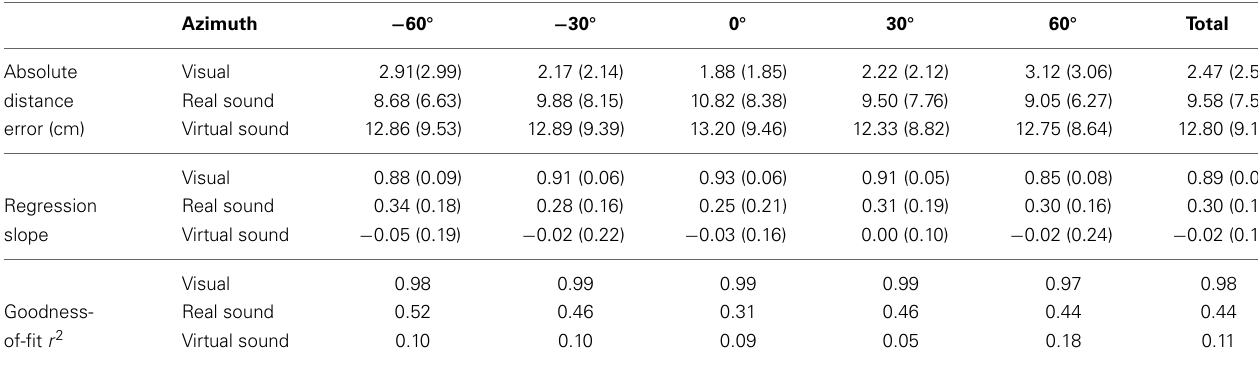
Table 4 | Mean absolute distance error (standard deviations in parenthesis), slope of the regression line, and goodness-of-fit criteria r 2 for each azimuth and rendering